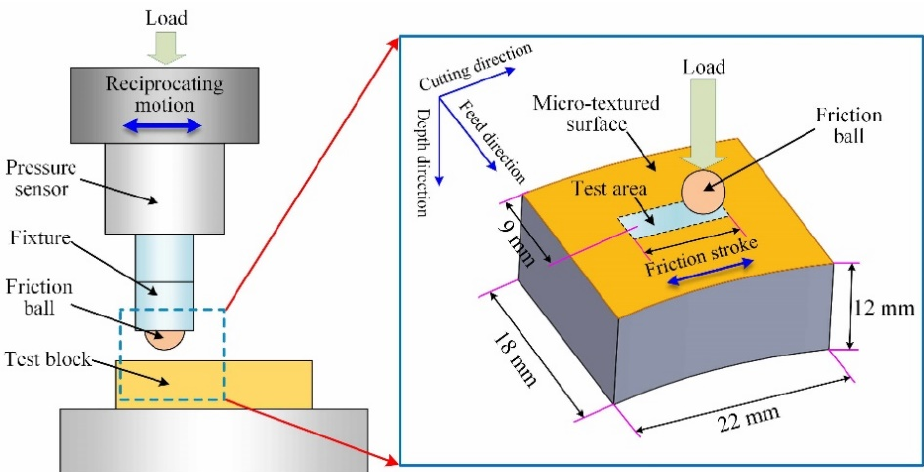
Figure 8. Principle diagram of the test mode of ball-on-disk.